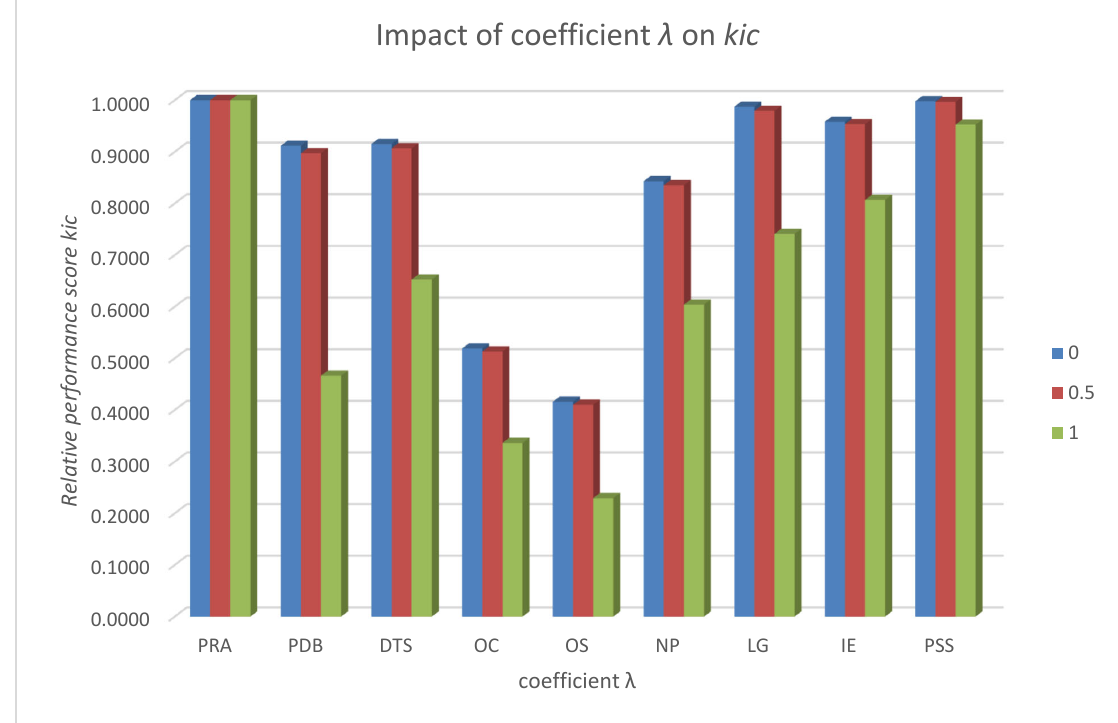
Fig. 5. Impact of coefficient λ on kic. Source: Computed by Authors, Created by Microsoft